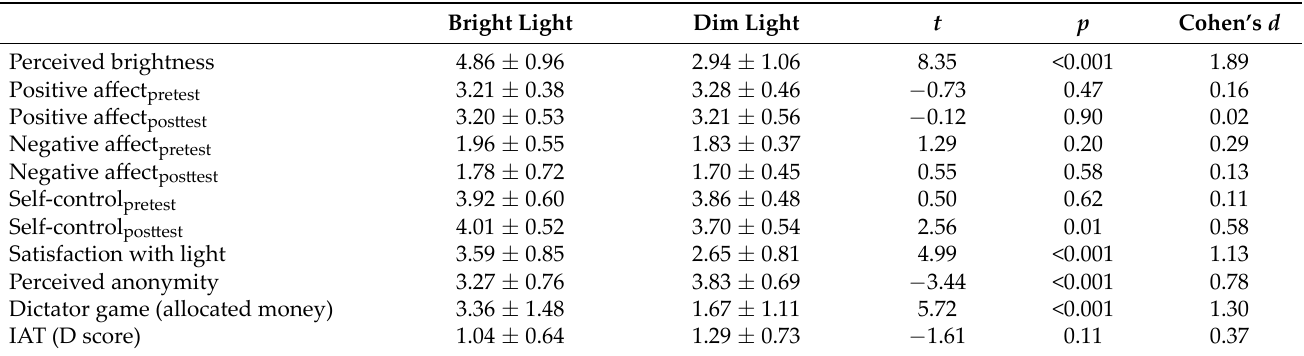
Table 3. Results of t‑tests for the differences between bright illuminance and dim illuminance on subjective feelings and